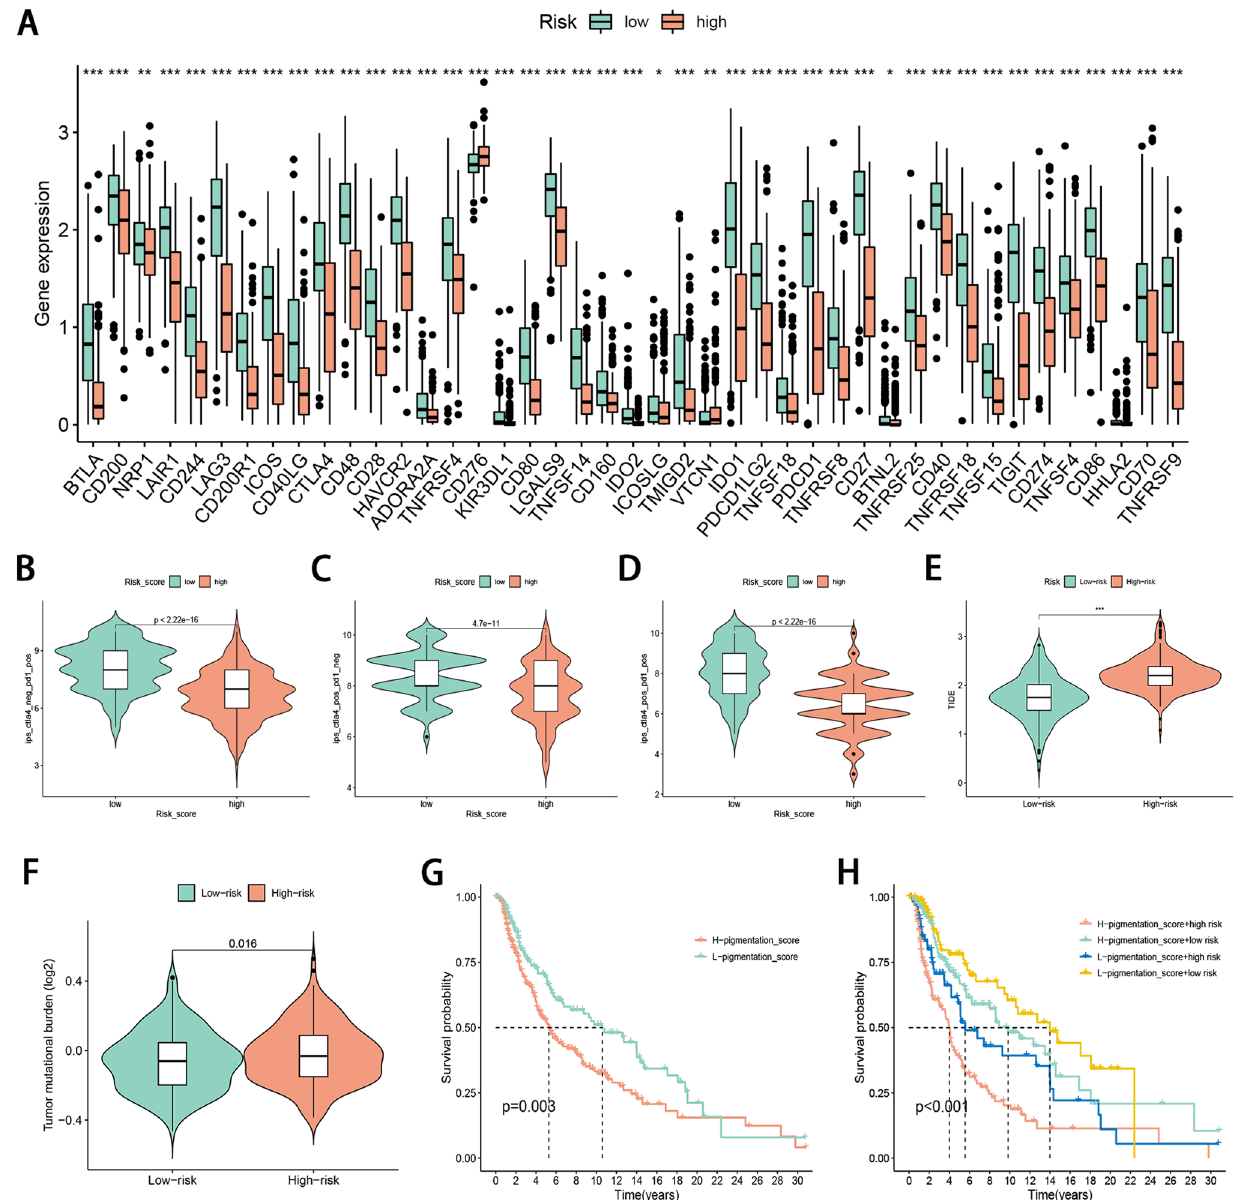
risk groups. ( E ) Difference of TIDE score between low- and high-risk groups. ( F ) Comparison of pigmentation score in the high- and low-risk groups. ( G ) Survival analysis of high and low pigmentation score group. ( H ) Survival analysis of melanoma stratified by pigmentation score and risk